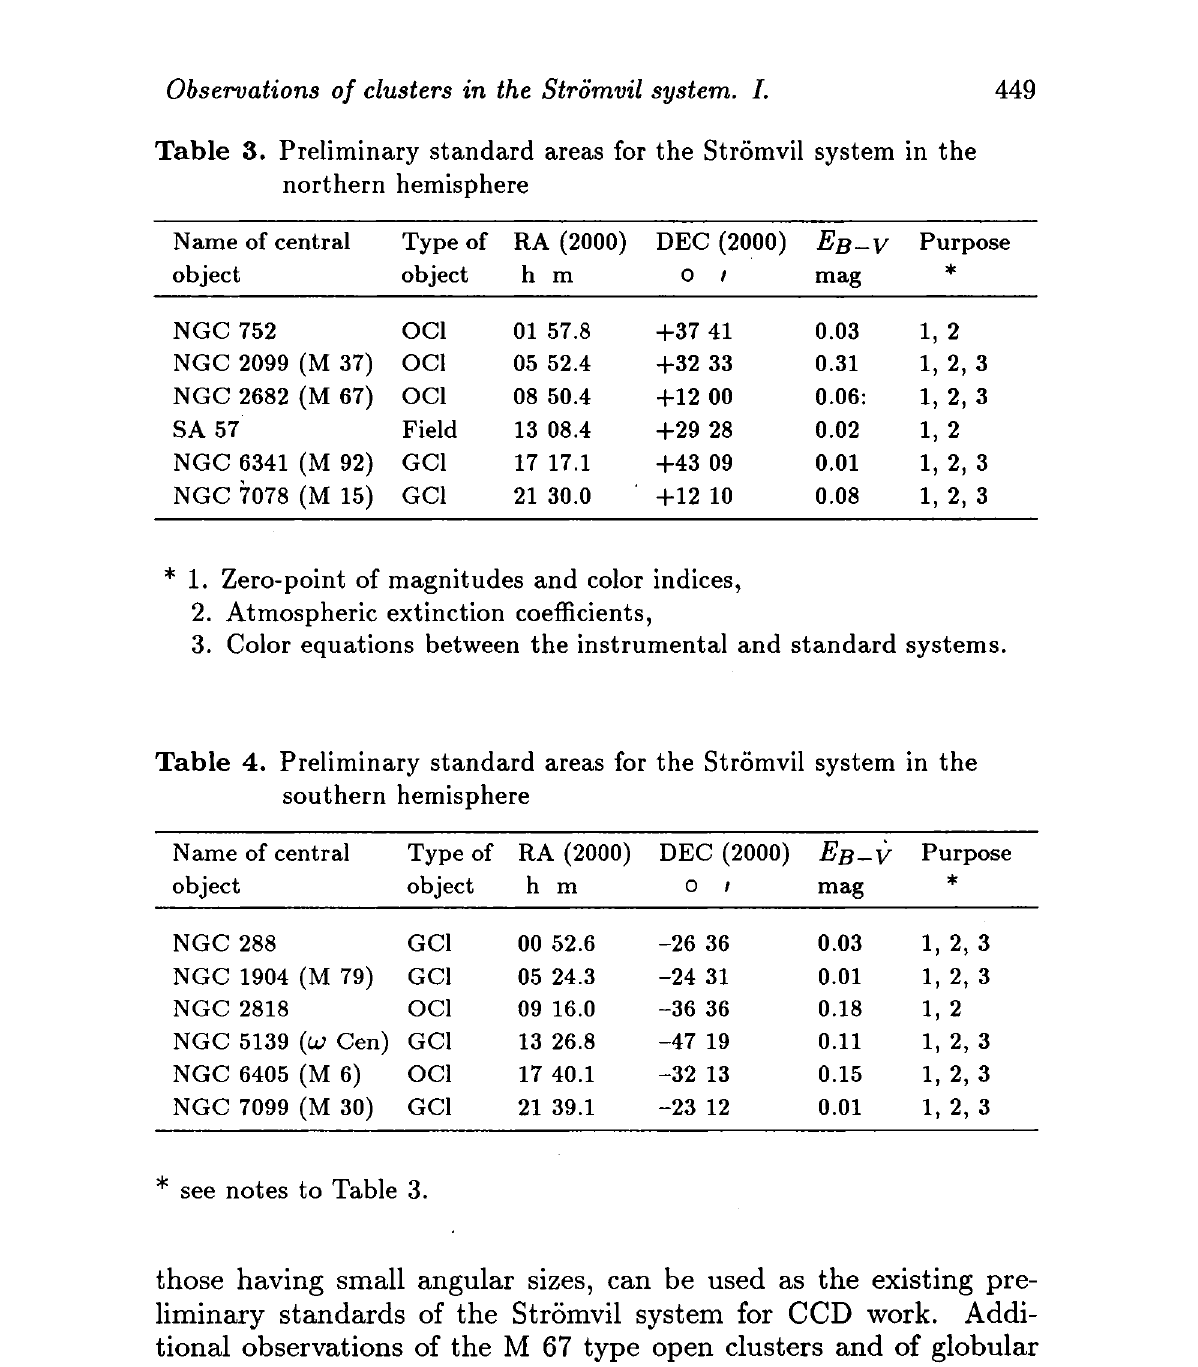
Table 4. Preliminary standard areas for the Strömvil system in the southern